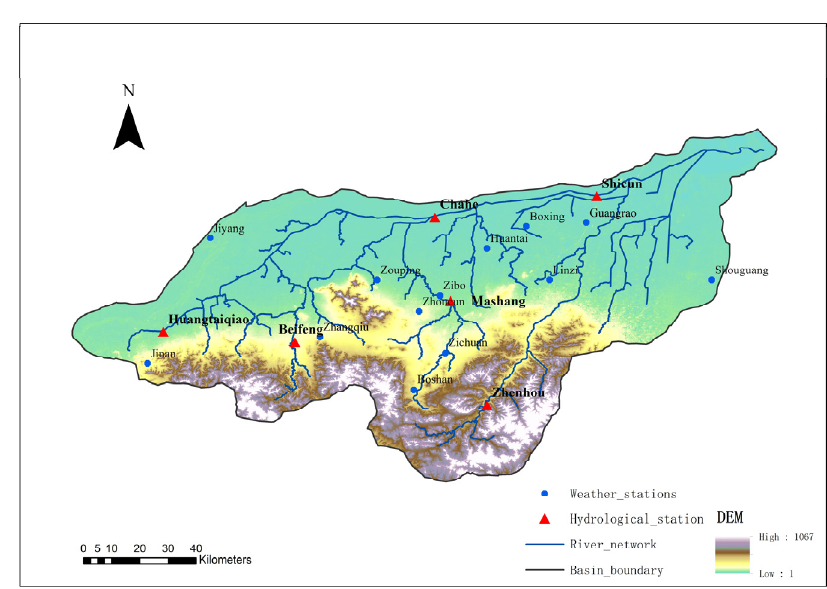
Figure 1. Location of the Xiaoqing River basin.